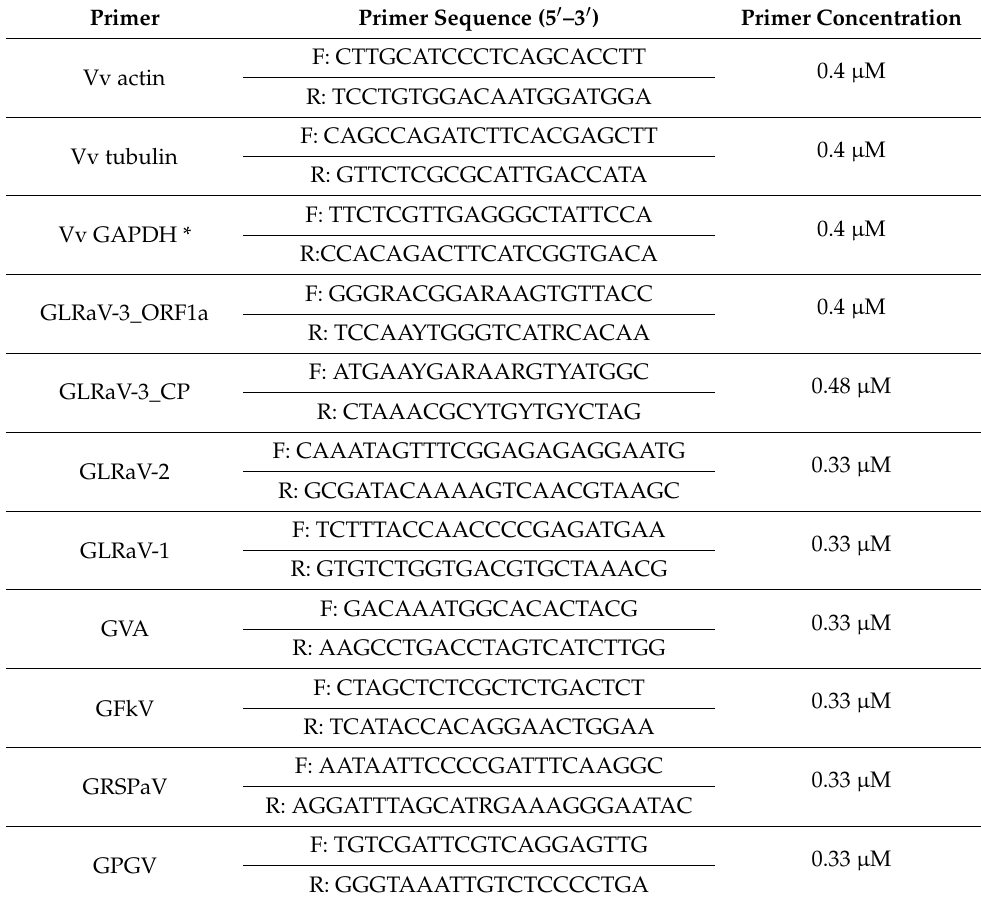
Table 4. Primer targeting Vitis vinifera host genes (Vv) and grapevine virus